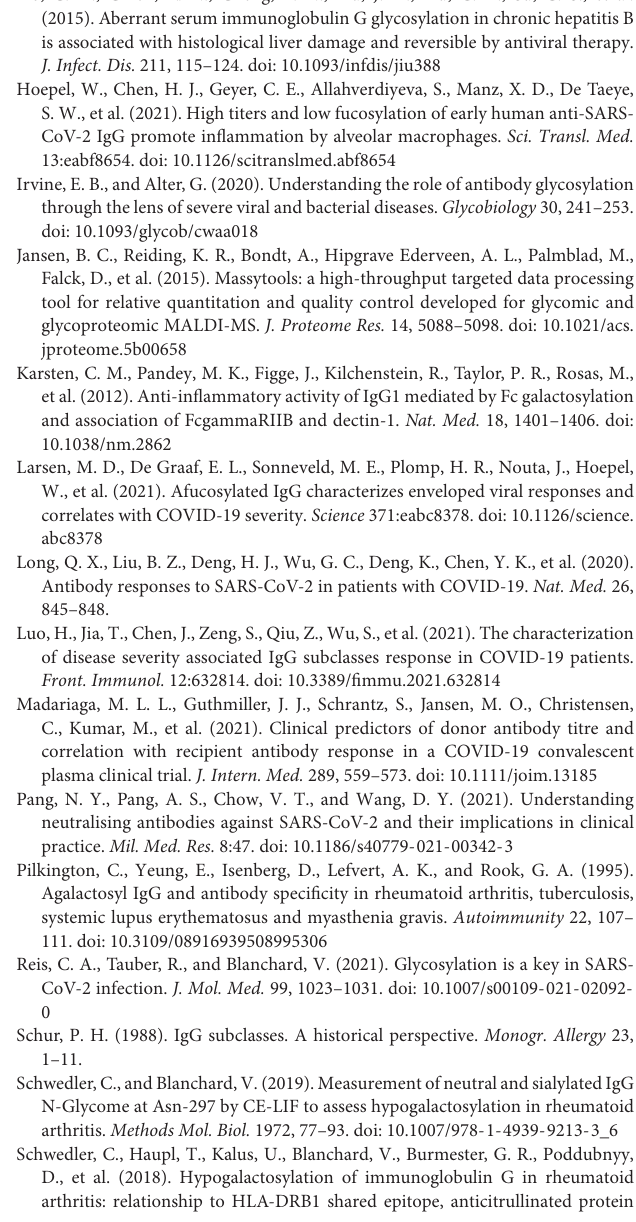
Supplementary Figure 4 | The age-related IgG glycosylation changes in both healthy controls (HC) and COVID-19 patients represented with the two major IgG 1 N -glycopeptide structures, namely (A) agalactosylated G0F and (B) digalactosylated G2F. Supplementary Figure 5 | Plasma CRP and anti-S IgG concentration in COVID-19 patients. (A,D) CRP and anti-S IgG levels at the beginning, in the middle, and at the end of patients’ hospital stay. (B,E) Longitudinal changes in CRP and anti-S IgG 1 levels in the course of the disease. (C,F) Correlation of CRP and anti-S IgG levels with patients’ age; the Y axes represent the difference ( (cid:49) ) in the respective parameter recorded between the last and first hospitalization time-point. Data points corresponding to the two deceased COVID-19 patients are indicated in red (patient 1) and blue (patient 2). For patient 1, only one measurement of CRP was performed. ** p < 0.01, *** p < 0.001.